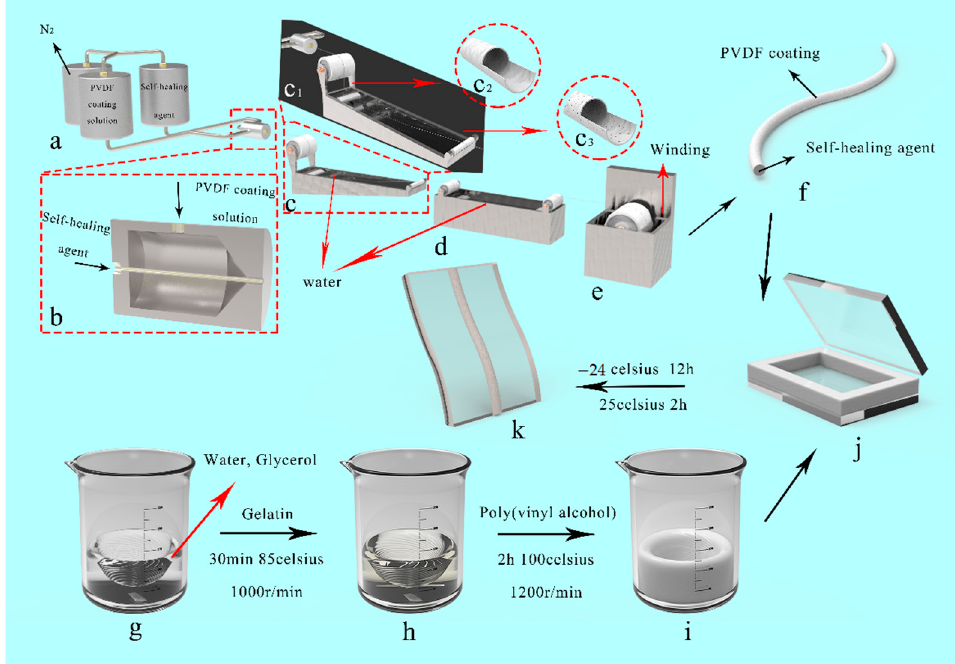
Figure 2. Illustration of preparation of self-nourishing and self-healing artificial skin. ( a – e ) Preparation of bionic microvascular. ( c1 – c3 ) Microporous structure preparation of the shell of the bionic microvascular. ( f ) Bionic microvascular. ( g – i ) Preparation of the gel. ( j ) The mold for the preparing artificial skin. ( k ) The self-nourishing and self-healing artificial skin.